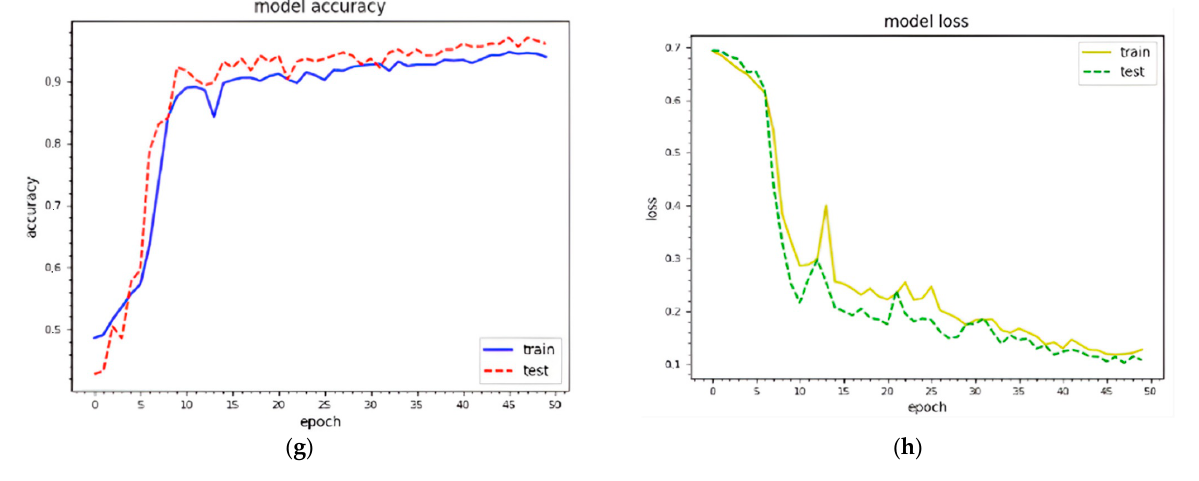
Figure 5. Epoch curves for training and testing data points using different visual representations for dataset 1 , i.e., 229 × 229, 256 × 256 (training accuracy, training loss; testing accuracy, testing loss). ( a ) 229 × 229 (classification); ( b ) 229 × 229 (classification); ( c ) 229 × 229 (detection); ( d ) 229 × 229 (detection); ( e ) 256 × 256 (classification); ( f ) 256 × 56 (classification); ( g ) 256 × 256 (detection); ( h ) 256 × 256 (detection).